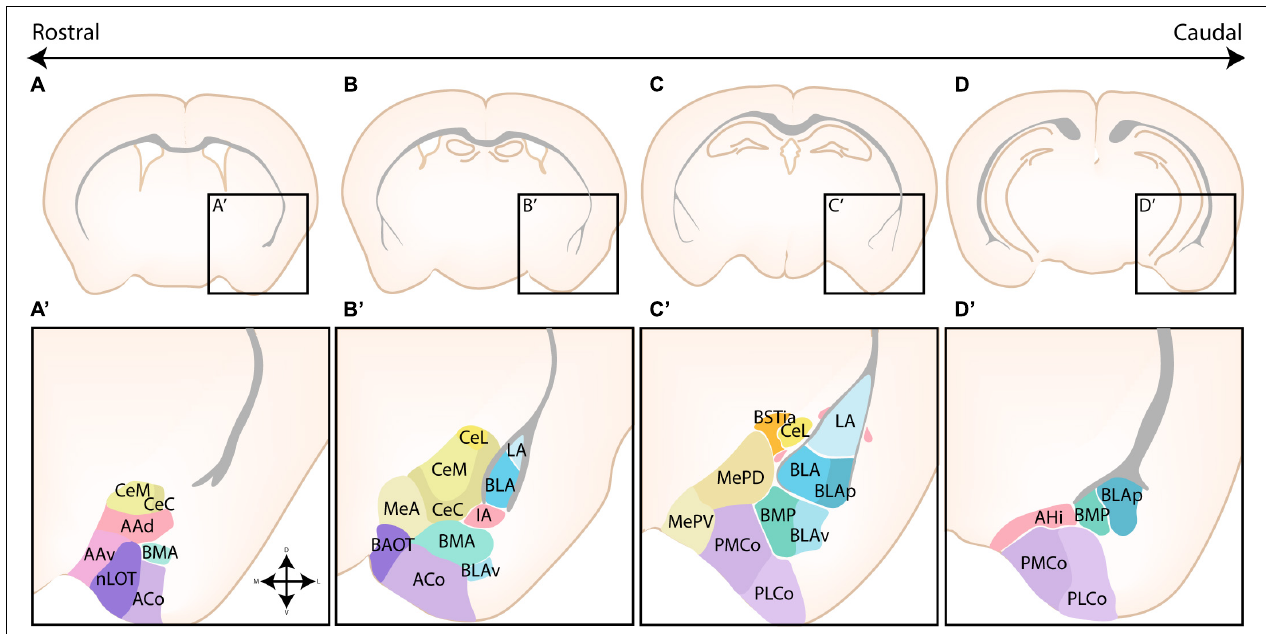
FIGURE 1 | The nuclear subdivisions of the amygdaloid complex. An overview of the nuclei of the basolateral complex (blue/green), the centromedial amygdala (yellow/orange), the cortical nuclei (purple) and transition areas (pink). (A,A’) Rostrally located nuclei of the amygdaloid complex include the anterior amygdala area (AAA), further subdivided into a ventral (AAv) and dorsal (AAd) subnucleus, the medial (CeM) and capsular (CeC) subnuclei of the central amygdala (CA), the anterior part of the basomedial nucleus (BMA), the nucleus of the lateral olfactory tract (nLOT) and the anterior cortical nucleus (ACo). (B,C,B’,C’) At intermediate levels, the basolateral complex (BLC) is fully visible, encompassing the lateral amygdala (LA), the basolateral amygdala [BLA, including its posterior (BLAp) and ventral (BLAv) divisions] and the anterior (BMA) subnuclei of the basomedial amygdala. The BLC is surrounded by the paracapsular (pink droplets) and main (IA) intercalated cell masses. Along the rostrocaudal axis the lateral (CeL) subnuclei of the CA, the anterior (MeA), posterodorsal (MePD) and posteroventral (MePV) subnuclei of the medial amygdala (MA) and the posteromedial (PMCo) and posterolateral (PLCo) subnuclei of the posterior cortical nuclei (PCo) emerge. The intraamygdaloid part of the bed nucleus of the stria terminalis (BSTia) closely surrounds the MePD and CeL. (D,D’) At the caudal pole of the amygdaloid complex, the amygdalo-hippocampal interface (AHi) emerges, joined at this level by the more posterior subnuclei of the BLC [posterior basomedial nucleus (BMP) and BLAp] and PCo (PMCo and PLCo). Figure is based on images from the Allen Brain Atlas (Allen Institute For Brain Science,